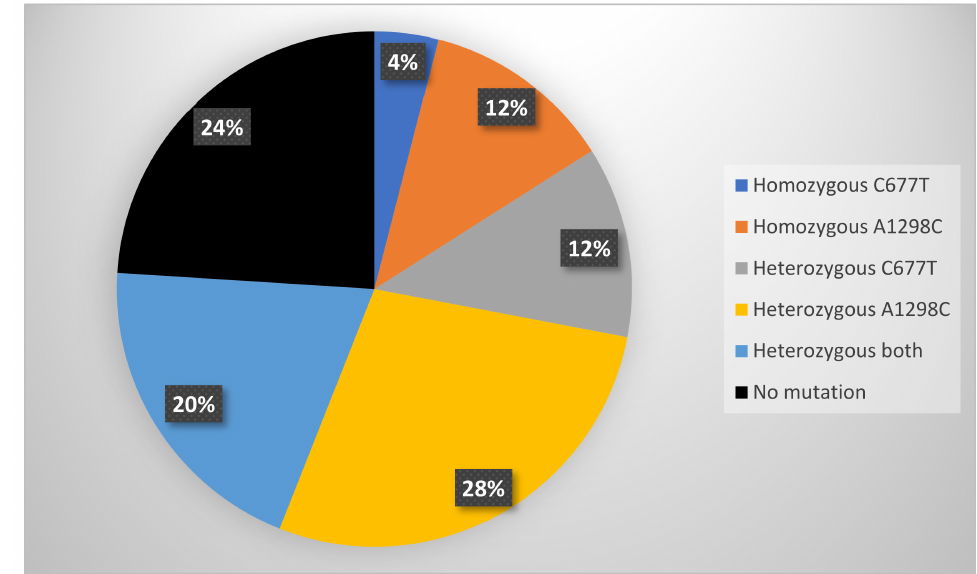
Figure 2. MTHFR mutations represented in the trial population: The trial population represented the entire range of C677T and A1298C MTHFR mutations, including a high proportion of compound heterozygous mutations.